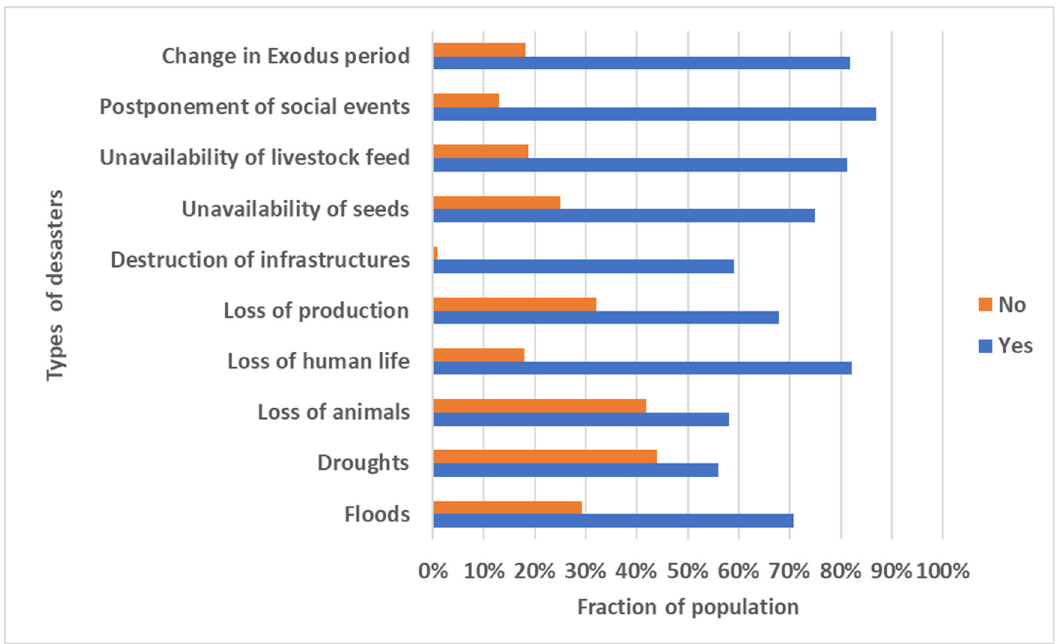
Figure 7. People’s perceptions of disaster risk reduction by using agrohydroclimatic early warning information.